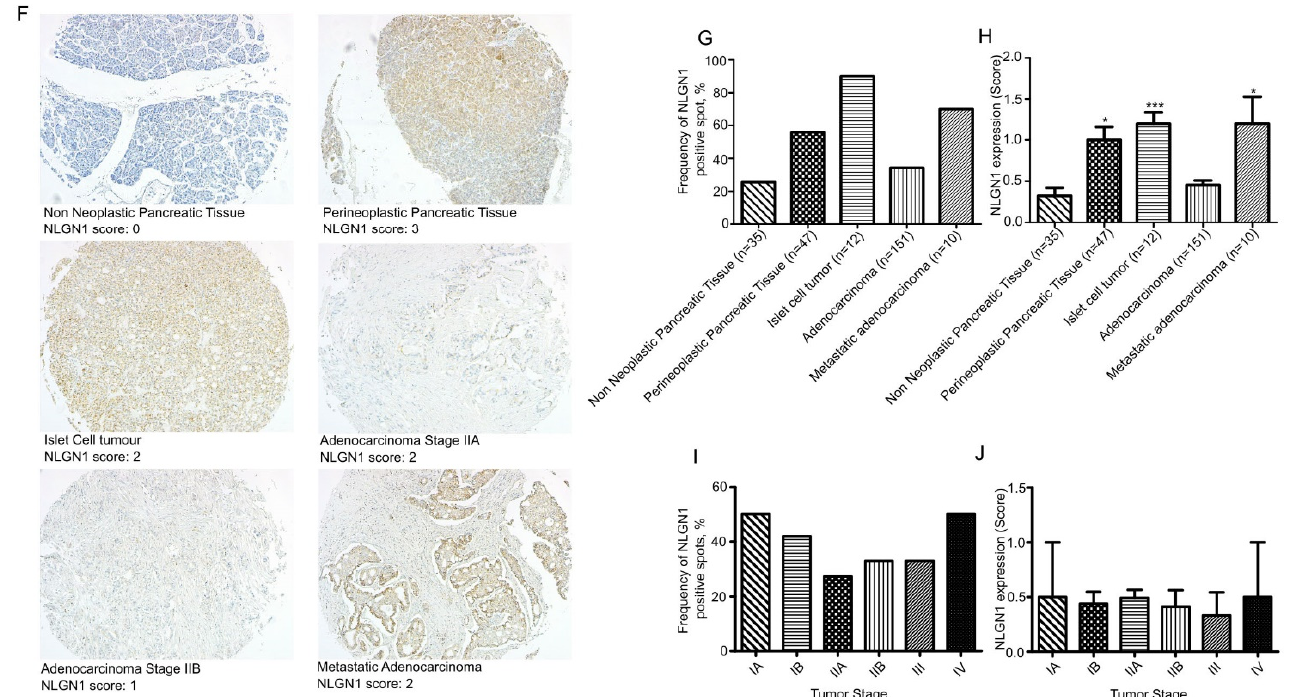
Figure 1. NLGN1 evaluation by IHC on a TMA of prostate adenocarcinoma Figure 1 . NLGN1 evaluation by IHC on a TMA of prostate adenocarcinoma (PR1921c—Biomax) ( A – E ) and two TMAs of pan- creatic adenocarcinoma (PA961f and PA2081c—Biomax) ( F – J ). ( A , F ) RepreScheme 1. protein expression by IHC in TMA cores and their relative score (original magnification 10×). ( B , D , G , I ) Distribution of NLGN1 protein expression according to the IHC positivity (present or absent) in terms of ( B , G ) pathology diagnosis, ( D ) Gleason score (GS), and ( I ) tumor stage. ( C , E , H , J ) Distribution of NLGN1 protein expression according to the IHC score, as present (1, 2, 3) or absent (0), in terms of ( C , H ) pathology diagnosis, ( E ) Gleason score (GS), and ( J ) tumor stage. Values are mean ± SE; one-way ANOVA with Bonferroni test: *, p < 0.05 **, p < 0.01 ***, p < 0.001.